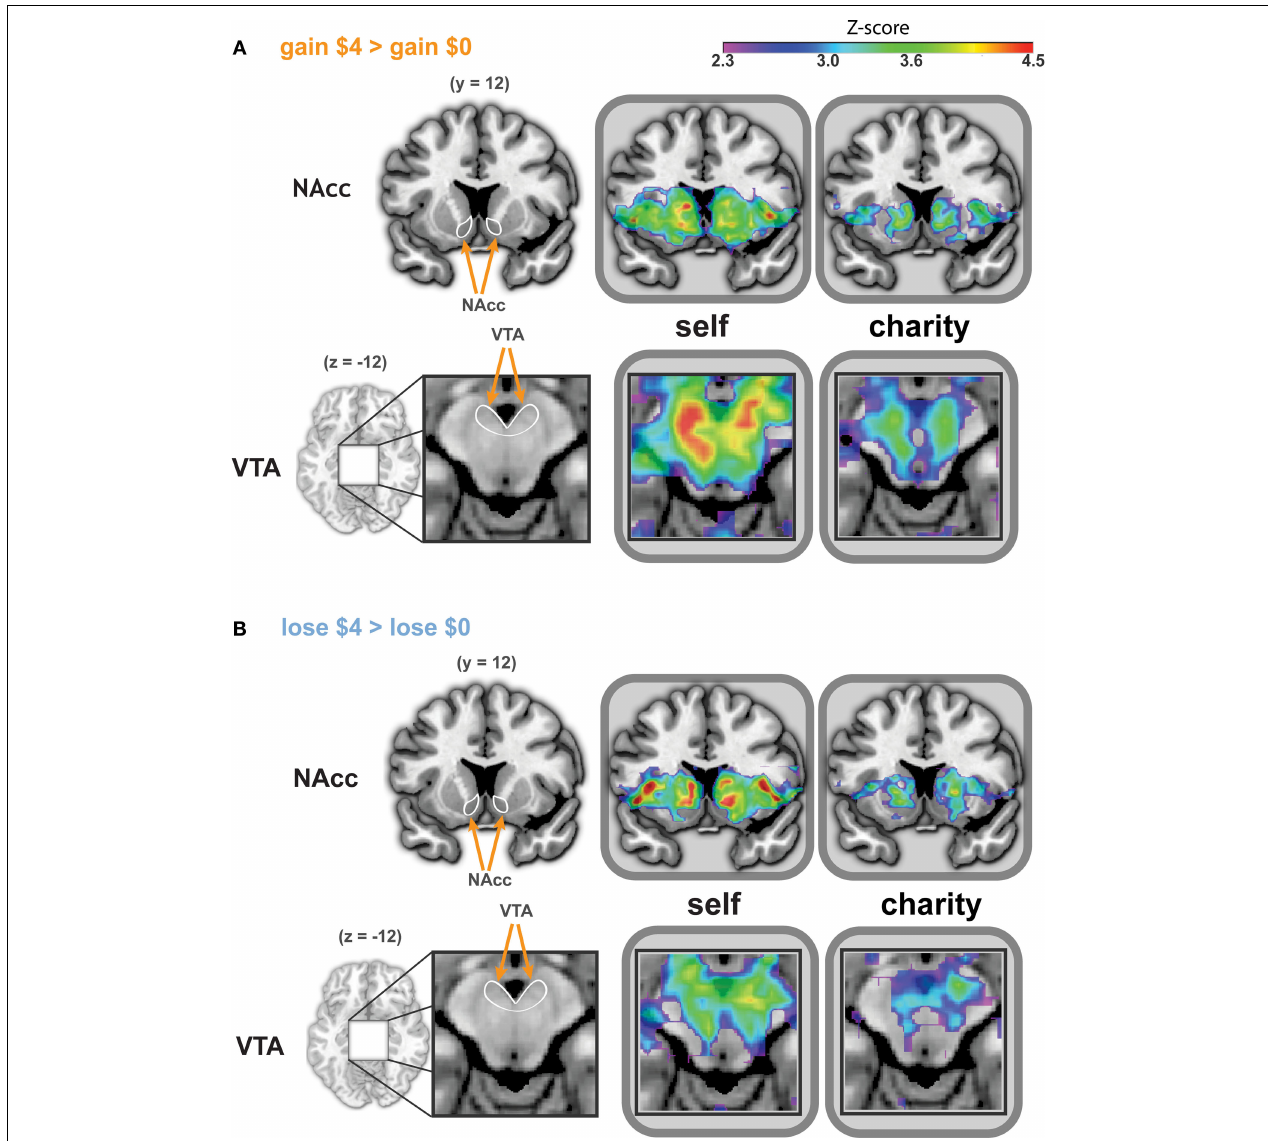
FIGURE 3 | Whole-brain analysis reveals similar patterns of activation during anticipation of gains and losses, whether participants played for self or a charity. Activated regions were larger and more signifi cant in the Self conditions. Activation peaks were present in the NAcc and VTA in all four treatments (i.e., anticipating gain, anticipating loss, playing for self, playing for a charity). ROIs for bilateral NAcc ( A and B , top ) are shown on a coronal image